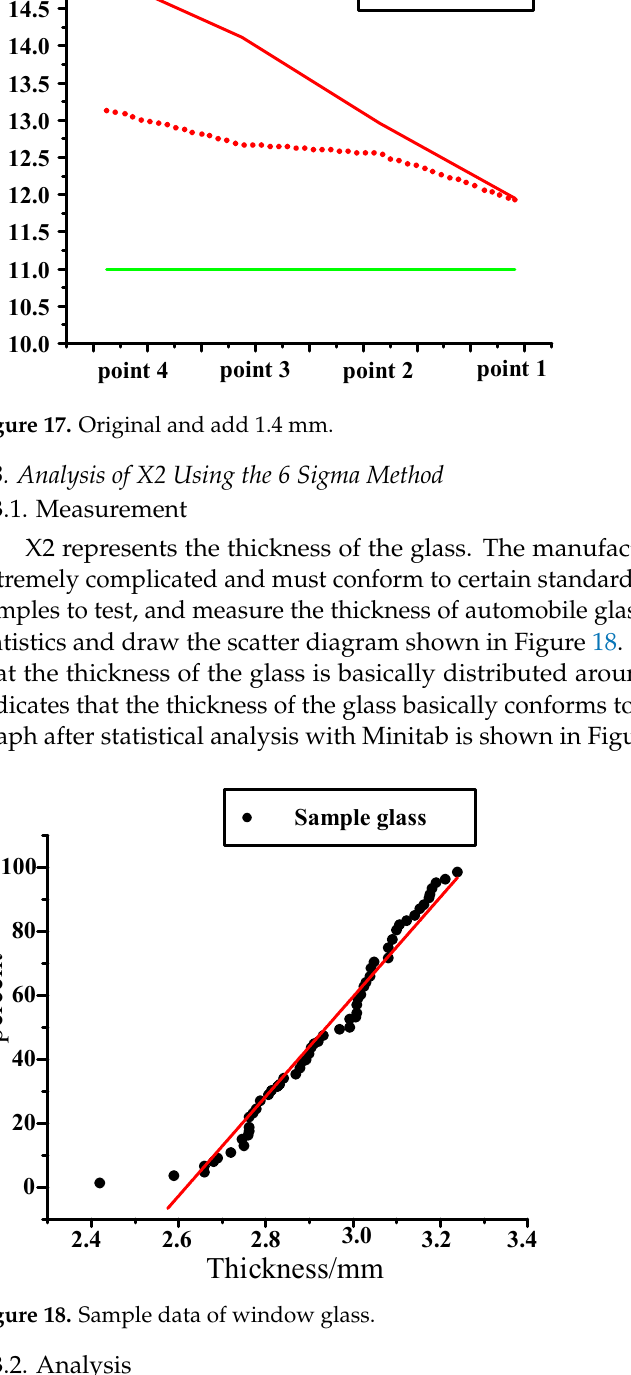
Figure 16. Window structure diagram before and after adding gasket. ( a ) Diagram of window without shim; ( b ) Diagram of window with shim.